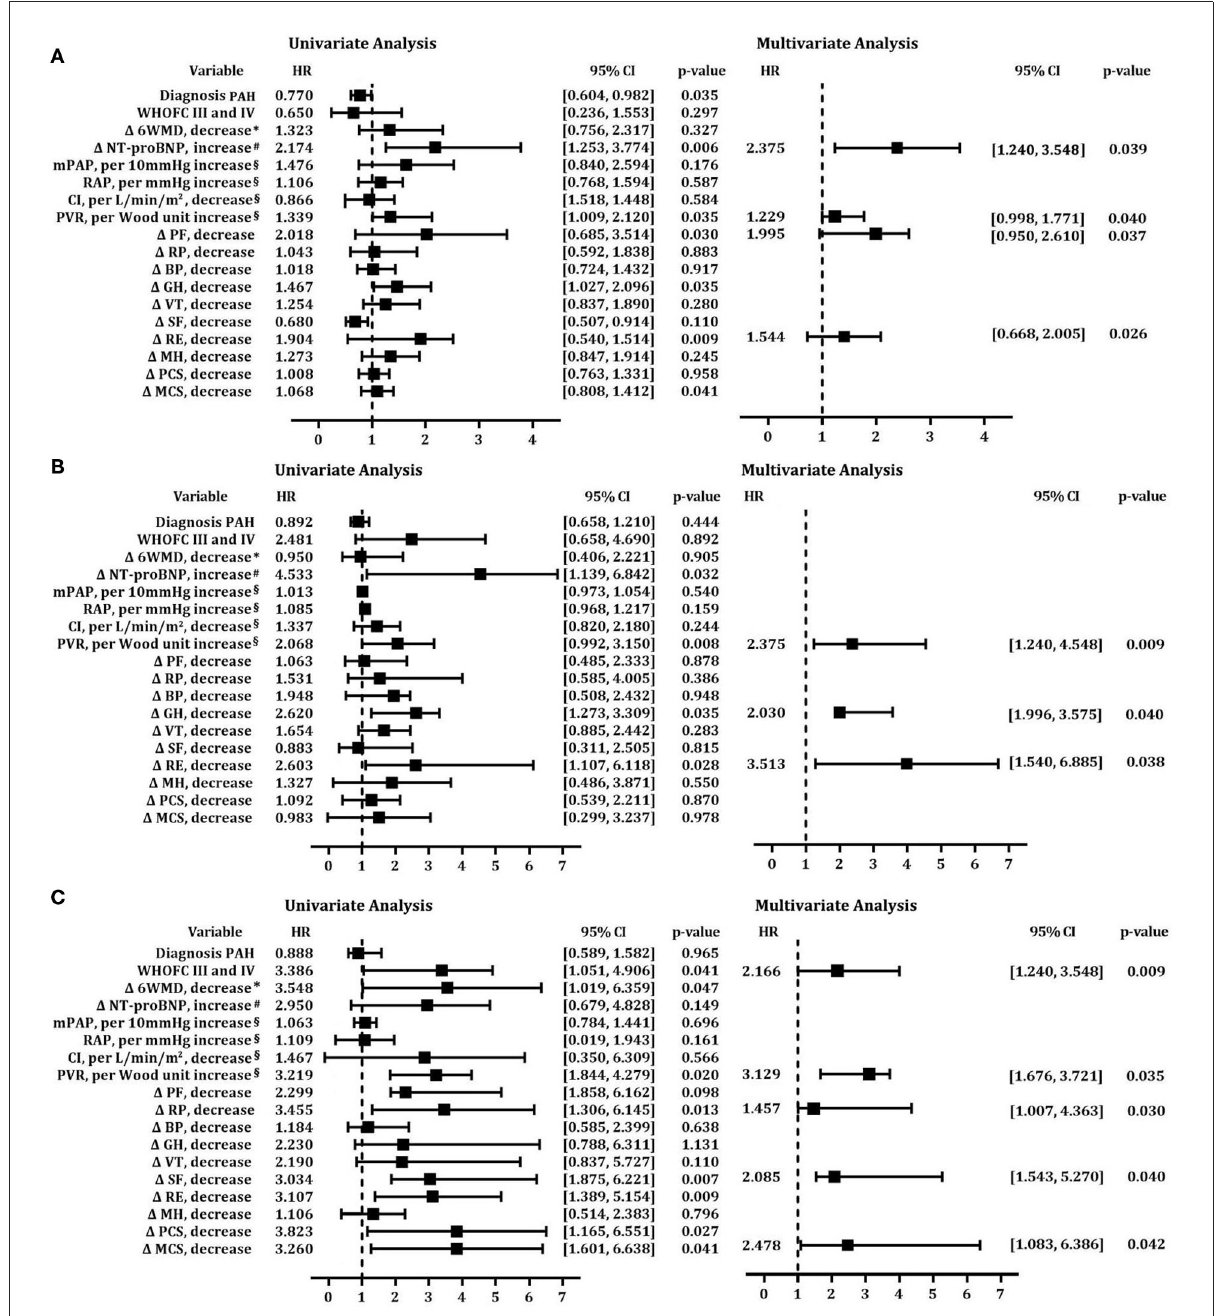
FIGURE6 Cox proportional hazards predictors of mortality at short-term, midterm, and long-term follow-ups. Univariate and multivariate models of risk factors after adjustment for age at (A) short-term follow-up; (B) midterm follow-up; (C) long-term follow-up. BP, body pain; CI, cardiac index; GH, general health; MCS, mental component summary; MH, mental health; mPAP, mean pulmonary arterial pressure; 6MWD, 6-min walk distance; NT-proBNP, N-terminal fragment of pro-brain natriuretic peptide; PAH, pulmonary arterial hypertension; PCS, physical component summary; PF, physical functioning; PVR, pulmonary vascular resistance; RAP, mean right atrial pressure; RE, role emotion; RP, role physical; SF, social functioning; VT, vitality; WHO FC, World Health Organization functional